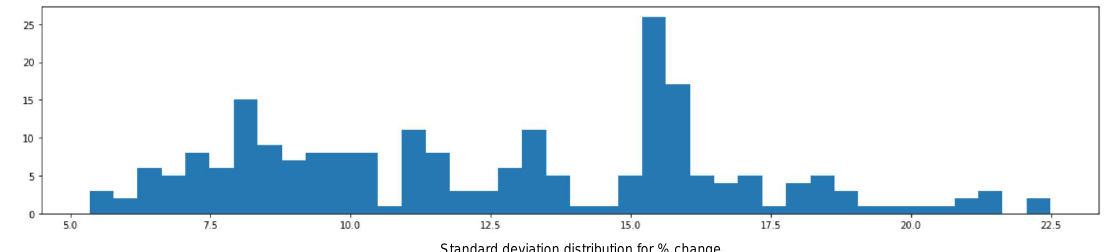
Figure 18. Distribution of the standard deviation of ∆ y across the cells. This distribution shows that there are cells with low variability and low variability in our grid dataset.